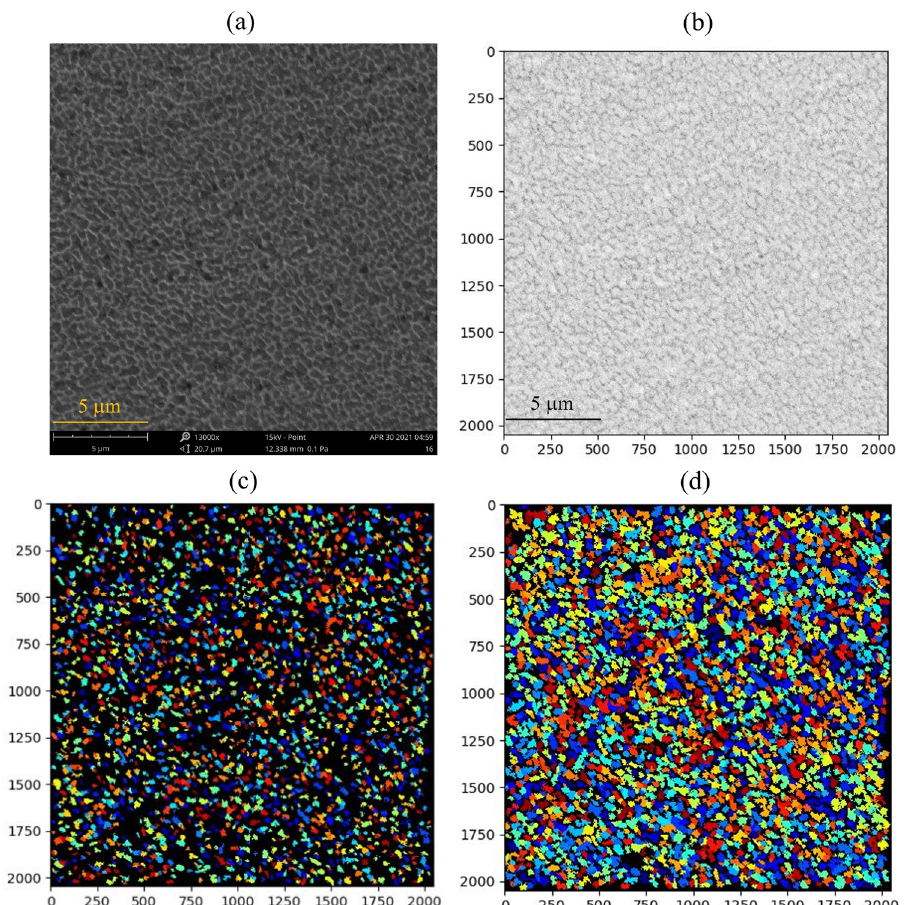
Figure 3: Fine cellular zone cell detection of sample no. 13 of CNTs/AlSi10Mg nanocomposites: ( a ) the original SEM image of the fi ne cellular zone in CNTs/AlSi10Mg nanocomposites, ( b ) the inversed gray image, ( c ) a cell nuclei map generated from the inversed gray image, and ( d ) a cell segmentation map showing high fi delity representation of the cell shape and size of the fi ne cellular